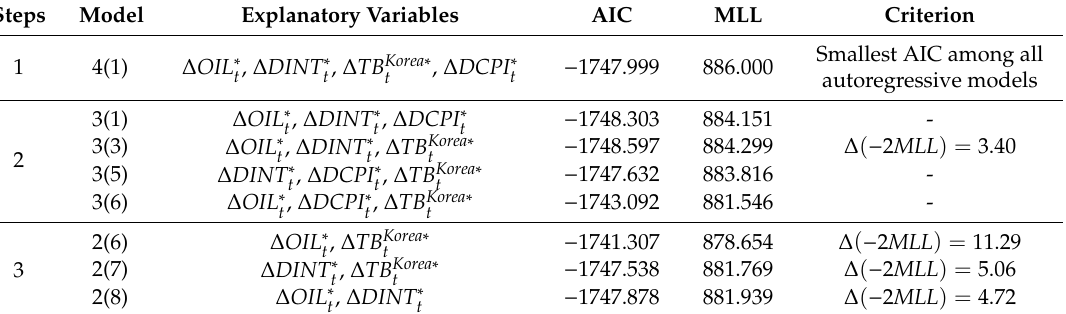
Table 2. Model Selection Process with Method 2 in